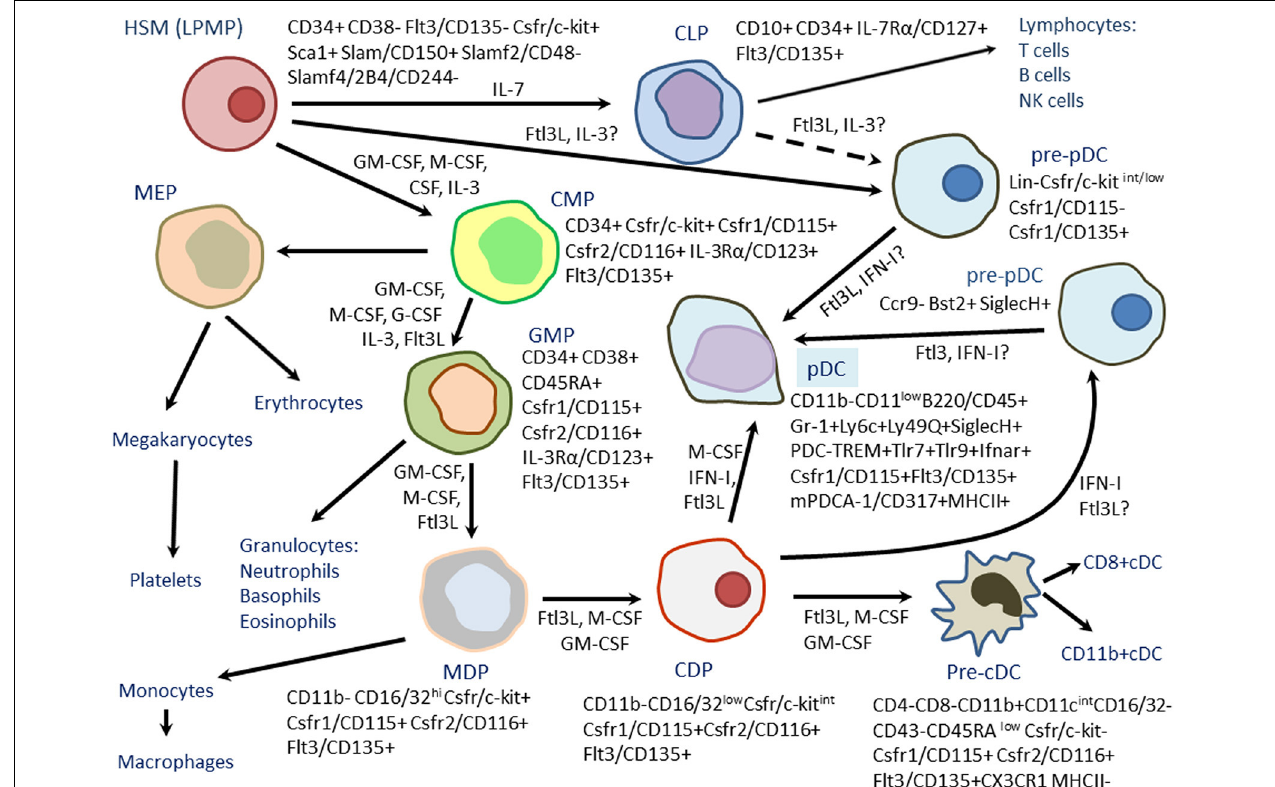
FIGURE 1 | Differentiation of mouse plasmacytoid dendritic cells (pDCs) from hematopoietic stem cells (HSCs) or lymphoid-primed multipotent progenitors (LPMPs). Bone-marrow hematopoiesis is a multistep process involving sequential generation of common lymphoid progenitors (CLPs), common myeloid progenitors (CMPs), megakaryote-erythroid progenitors (MEPs), granulocyte-macrophage progenitors (GMPs), macrophage dendritic cell progenitors (MDPs), common dendroid cell progenitors (CDP), and conventional dendritic cell precursors (pre-cDCs). Generally, MDPs and CDPs